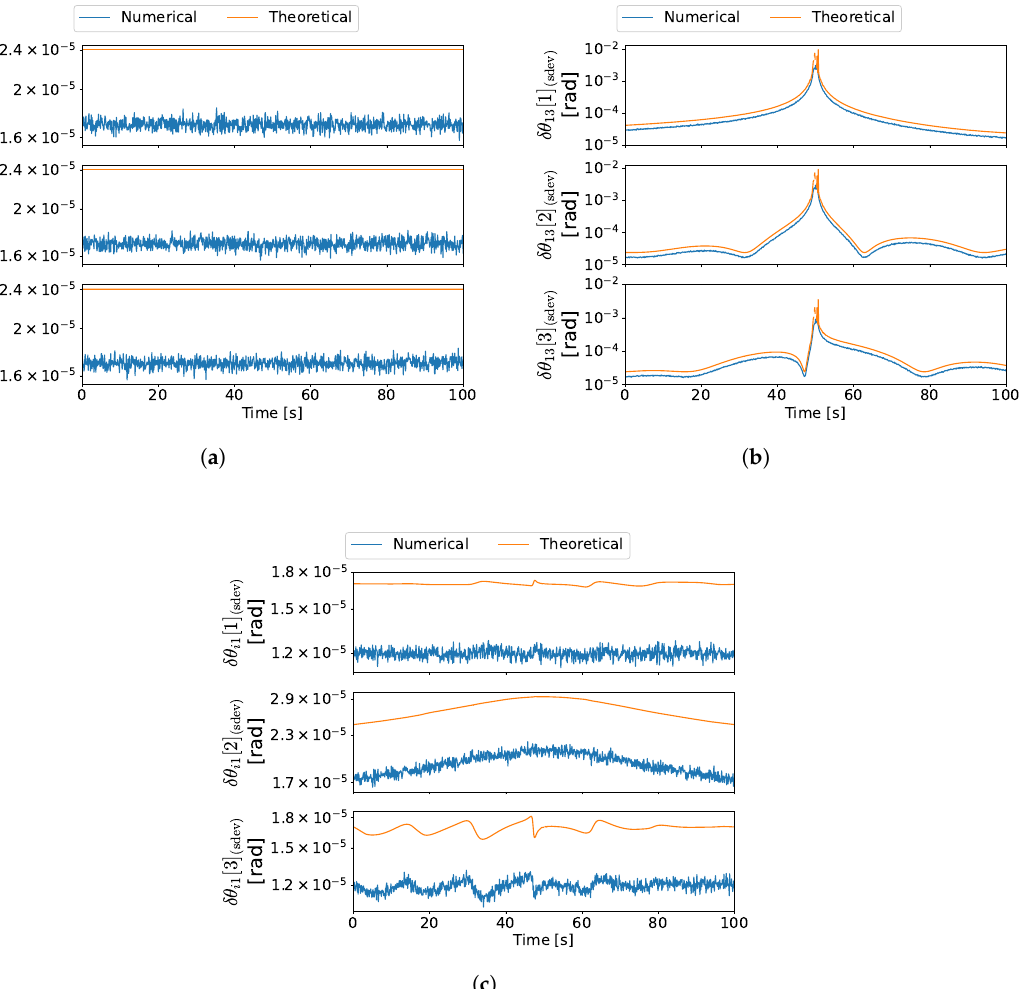
Figure 6. Attitude error standard deviations in experience 1. ( a ) R 1 experience 1, ( b ) R 1 error standard deviation in experience 1, ( c ) R I 3 experience 1.